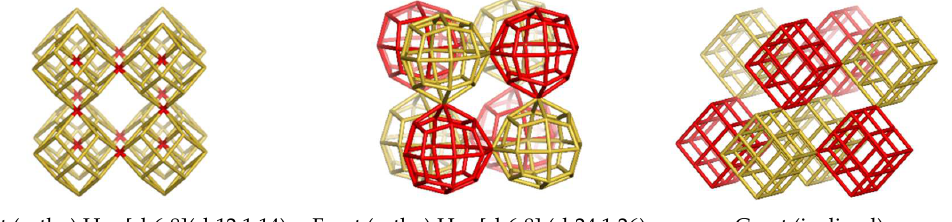
Figure 5. Corner-coalesced nets.